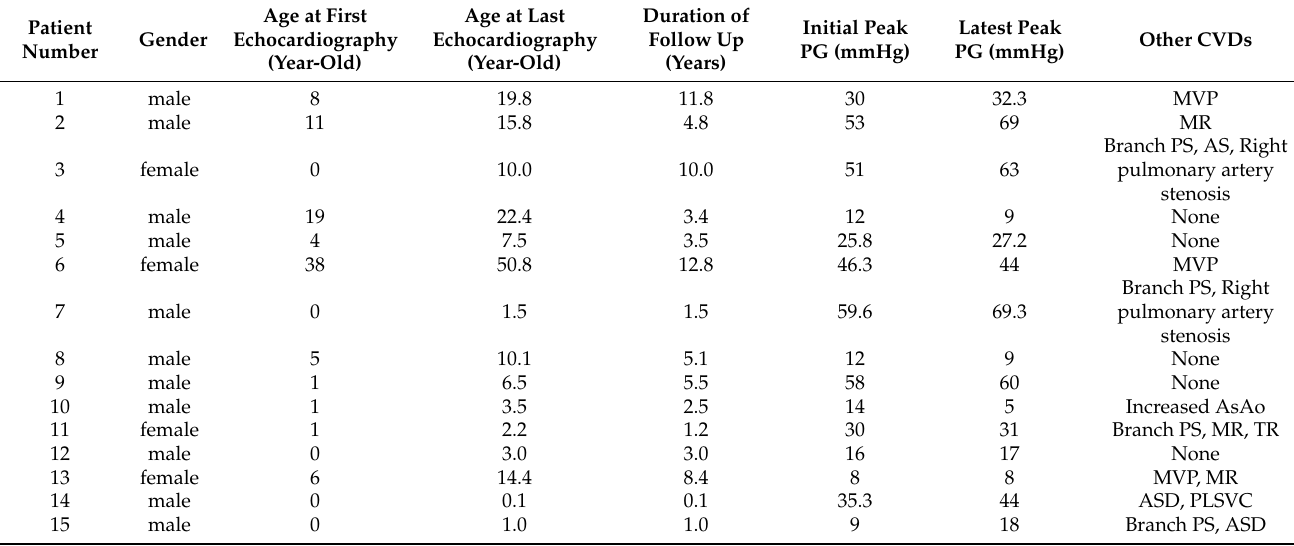
Table 3. The baseline characteristics and comorbidities in SVAS.